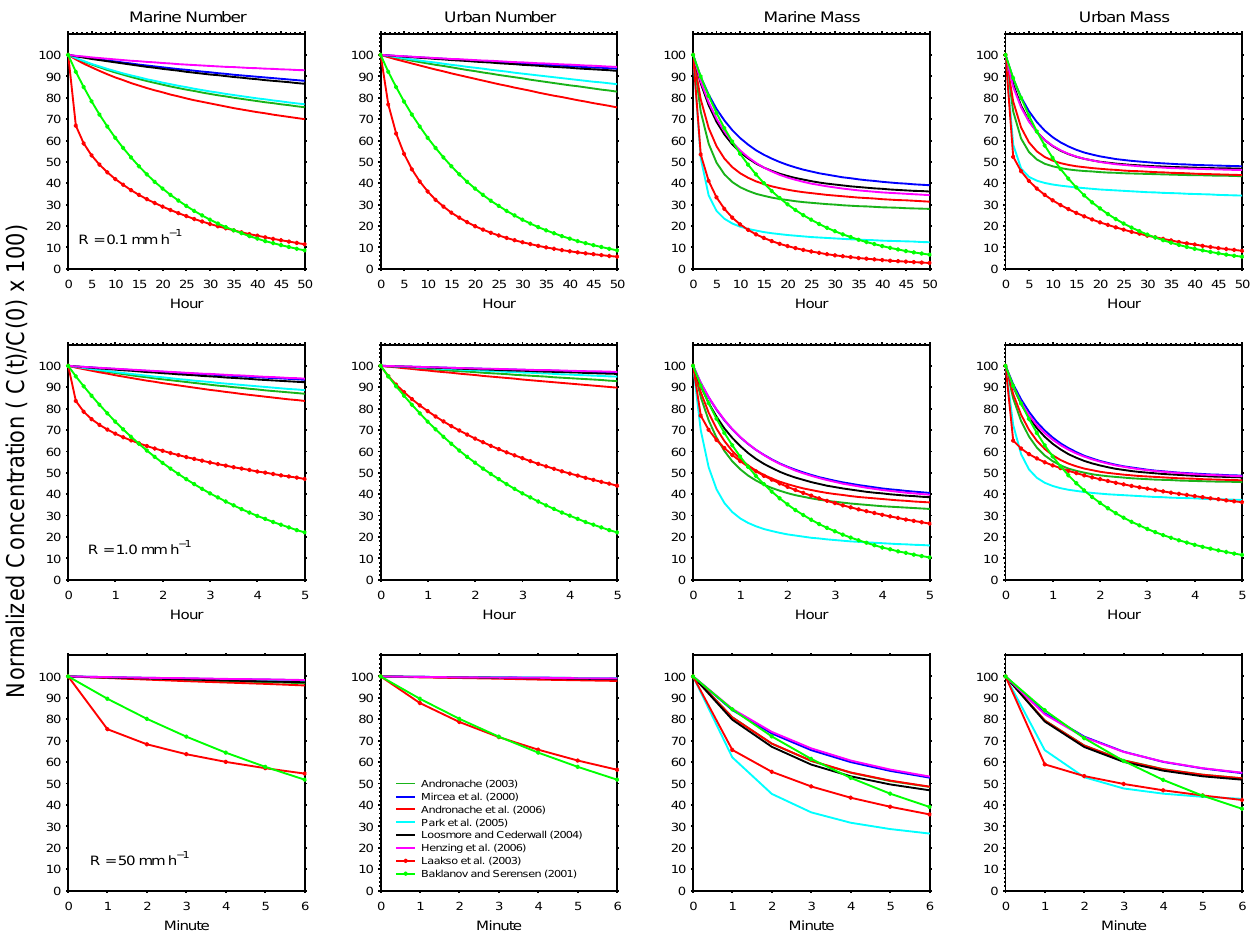
Fig. 9. Time evolution of the normalized bulk (i.e., integrated over the entire particle size spectrum) particle number concentration (first two columns) and mass concentration (last two columns) for typical marine and urban aerosol populations for a total rainfall of 5mm for three different rainfall intensities, 0.1mmh − 1 (the first row), 1mmh − 1 (the second row), and 50mmh − 1 (the third row), calculated using eight different 3 parameterizations from Table 3. The particle number and mass concentrations are normalized to their initial values. Plain solid lines denote theoretical 3 parameterizations and lines with symbols denote empirical 3